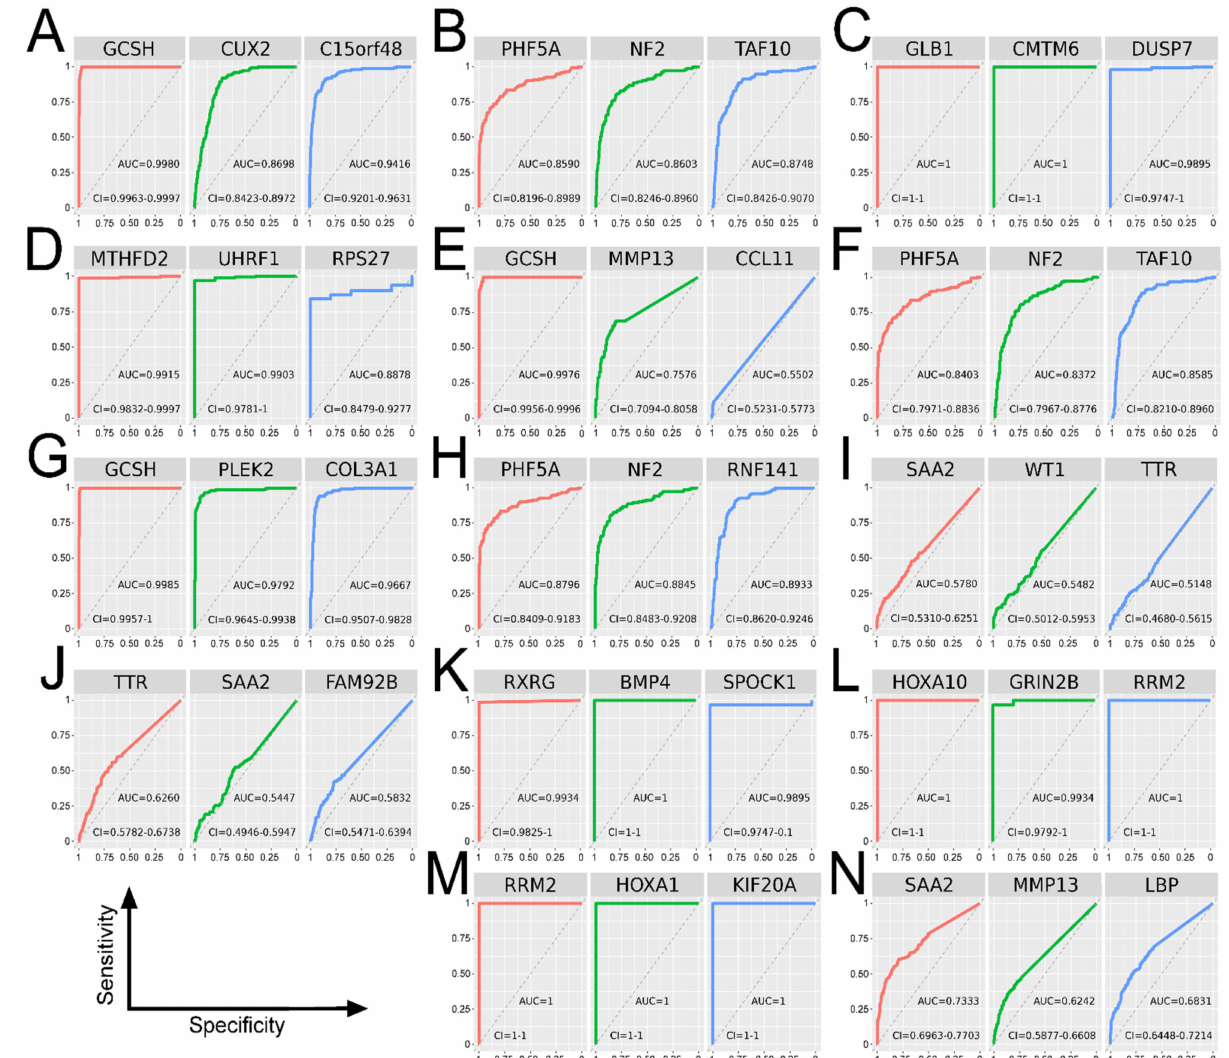
Figure 5. ROC analysis of top genes from comparisons—RNA-seq data. ( A ) GBM vs. LGG, set 1 + 3 + 6. ( B ) GBM vs. LGG, set 2 + 4 + 5 + 7. ( C ) GBM vs. NT, set 5 + 6. ( D ) LGG vs. NT, set 1. ( E ) G4 vs. G3, set 1 + 3 + 6. ( F ) G4 vs. G3, set 2 + 4 + 5 + 7. ( G ) G4 vs. G2, set 1 + 3 + 6. ( H ) G4 vs. G2, set 2 + 4 + 5 + 7. ( I ) G3 vs. G2, set 1 + 3 + 6. ( J ) A vs. OA and OD, set 1 + 5 + 7. ( K ) Untr GBM vs. Tr, set 1 + 4 + 5 + 6. ( L ) Untr GBM vs. NT, set 1 + 4 + 5 + 6. ( M ) Tr vs. NT, set 1 + 4 + 5 + 6. ( N ) >45 vs. ≤ 45, set 1 +